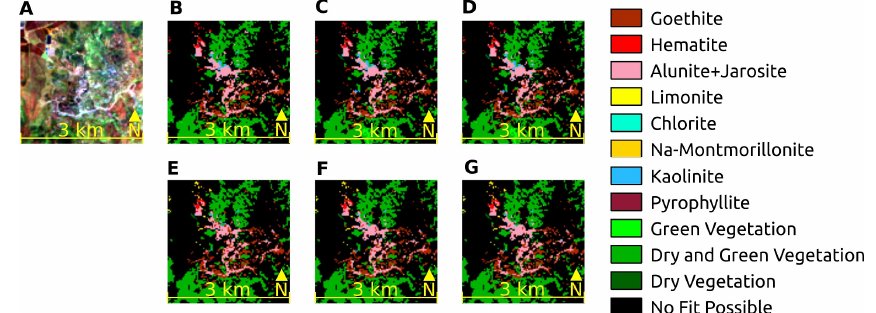
Figure 7. Color coded best weighted fit results from EnGeoMAP 2.0 for the simulated EnMAP Rodalquilar subset ( A ) Color composite (R: 2226 nm, G: 912 nm, B: 554 nm) using different fitting methods; ( B ) Linear Regression; ( C ) Linear Correlation; ( D ) Modified Spectral Angle Mapper (MSAM);